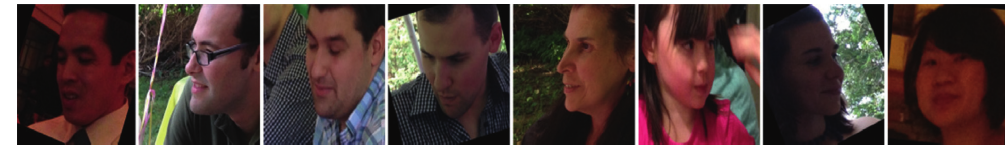
Figure 8: Samples of face images with misclassified age group or gender.